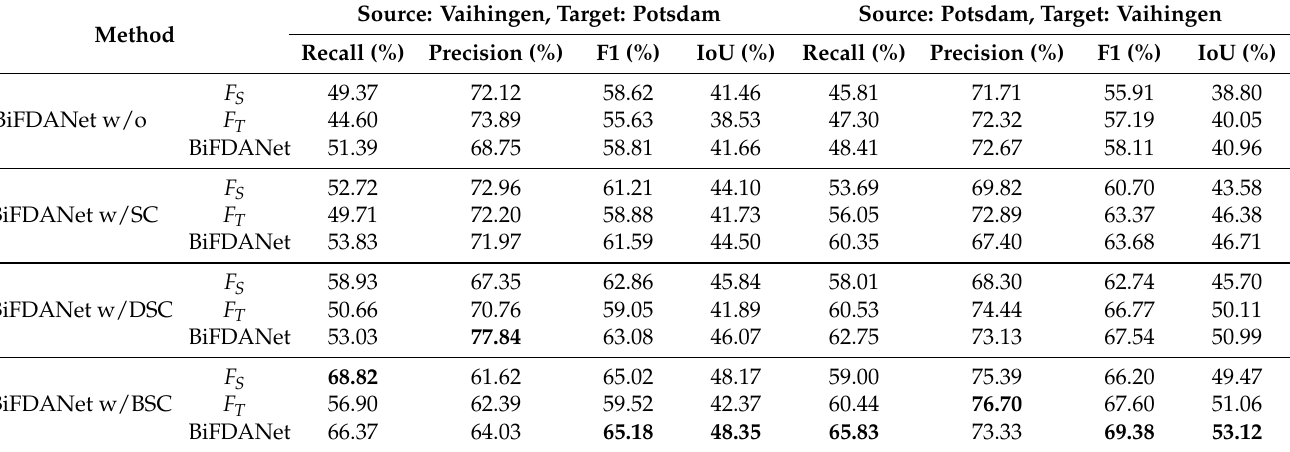
Table 5. Evaluation results of different semantic consistency loss on ISPRS dataset. The best values are in bold.